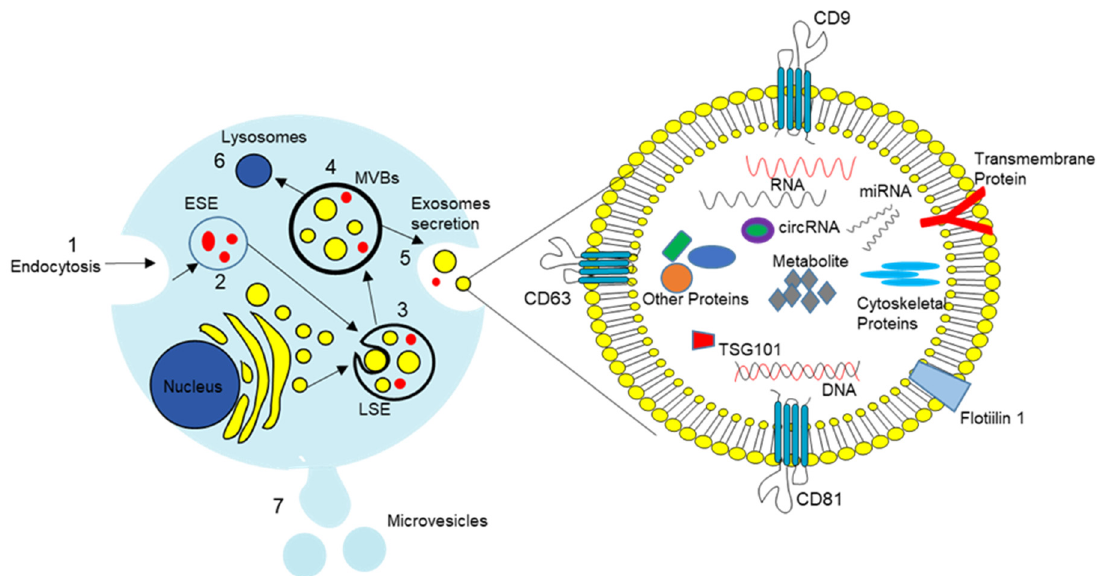
Figure 1. Illustration of the biogenesis of EVs and their cargo. Exosomes, generated by endocytosis (1) of the endosomal membrane, form early (2) and late (3) endosomes and multivesicular bodies (MVBs) (4). After the fusion of the MVBs with the plasma membrane, exosomes are released into the extracellular space (5). MVBs fuse with autophagosomes and are degraded in lysosomes (6). Microvesicles, by contrast, are generated by simple budding of the plasma membrane (7). Exosomes carry proteins, miRNA, mRNA, DNA, and lipids. Tetraspanins (CD9, CD63, and CD81) on the sur- face serve as markers for EV identification.